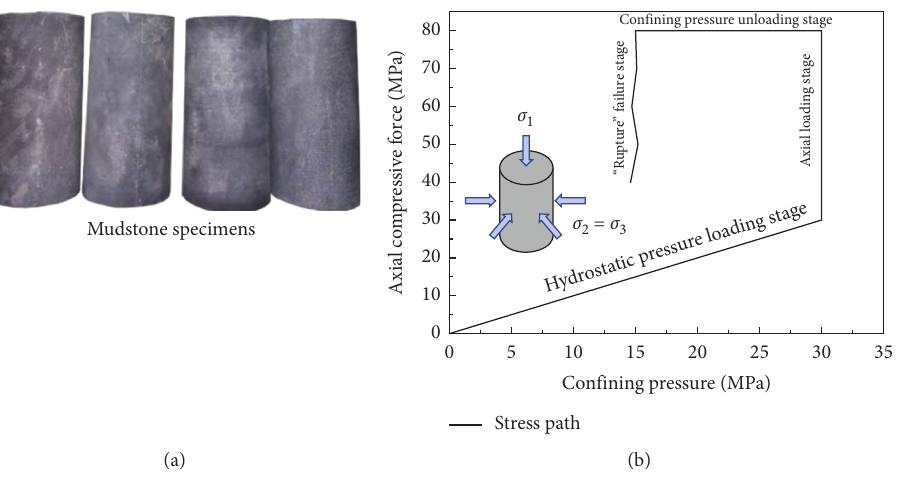
Figure 3: Mudstone specimens and stress path during the confining pressure unloading